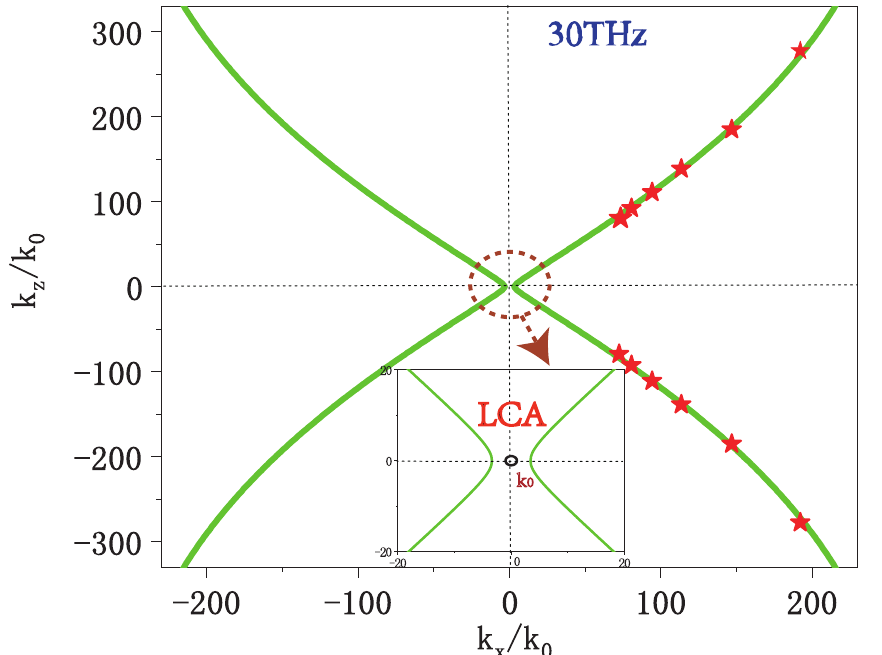
Figure 2. Iso-frequency contour of the graphene-silicon HMM in x-z plane at 30THz. Hyperbolic curves (green line) represent allowed propagating modes inside the multilayered metamaterial (calculated from Equation (3)), and the red stars denote resonant cavity modes. The black circle with radius k 0 around the origin represents a cross section of light cone in air